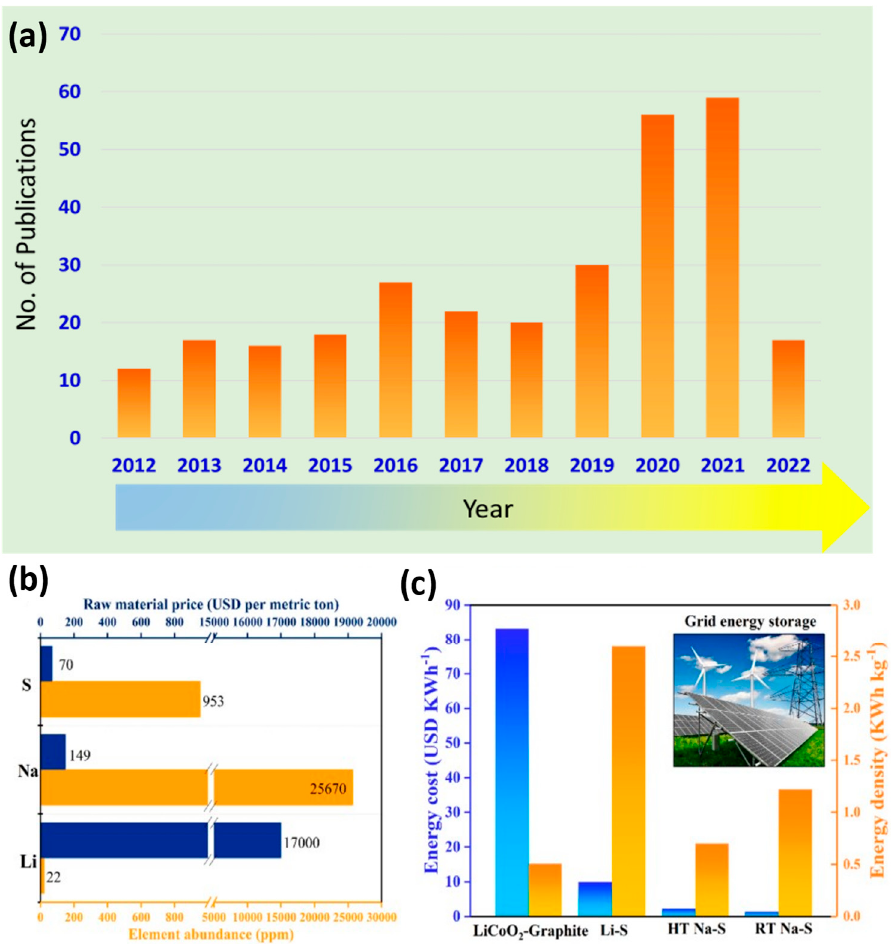
Figure 1. ( a ) Rise in the number of publications on RT-NaSBs in the last 10 years (2012–2022 March, data collected from Scopus) and comparison of ( b ) element abundance and raw material price and ( c ) projected reduction in cost per kWh in terms of energy density achieved for RT-NaSBs compared to that of prominent rechargeable battery technologies. Reproduced with permission [15]. Copyright 2021, American Chemical Society.